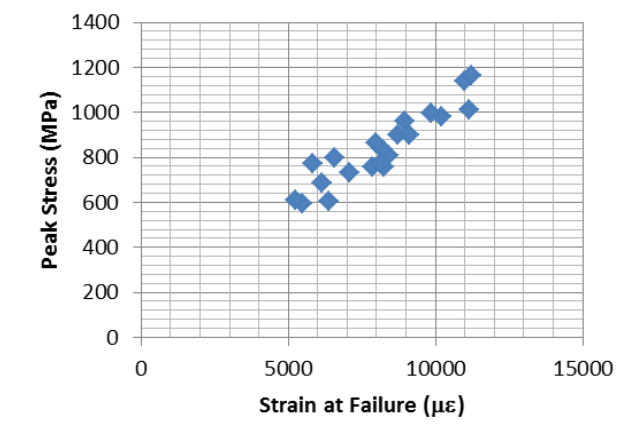
Figure 8. Strain at failure vs. peak